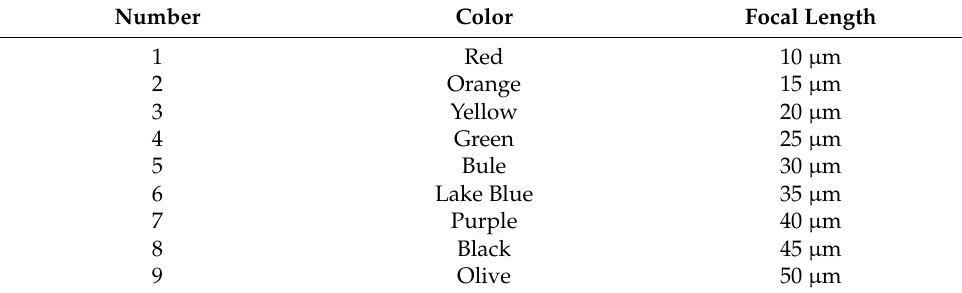
Figure 5. Brief evaluation of focusing quality. ( a ) The degree of focal length shift. The illustration depicts the change of half-height width at different focal lengths. ( b , c ) The normalized electric field intensity distribution of different focal lengths in transmission plane and focal plane, respectively. Table 1. Table of the color and corresponding focal lengths.